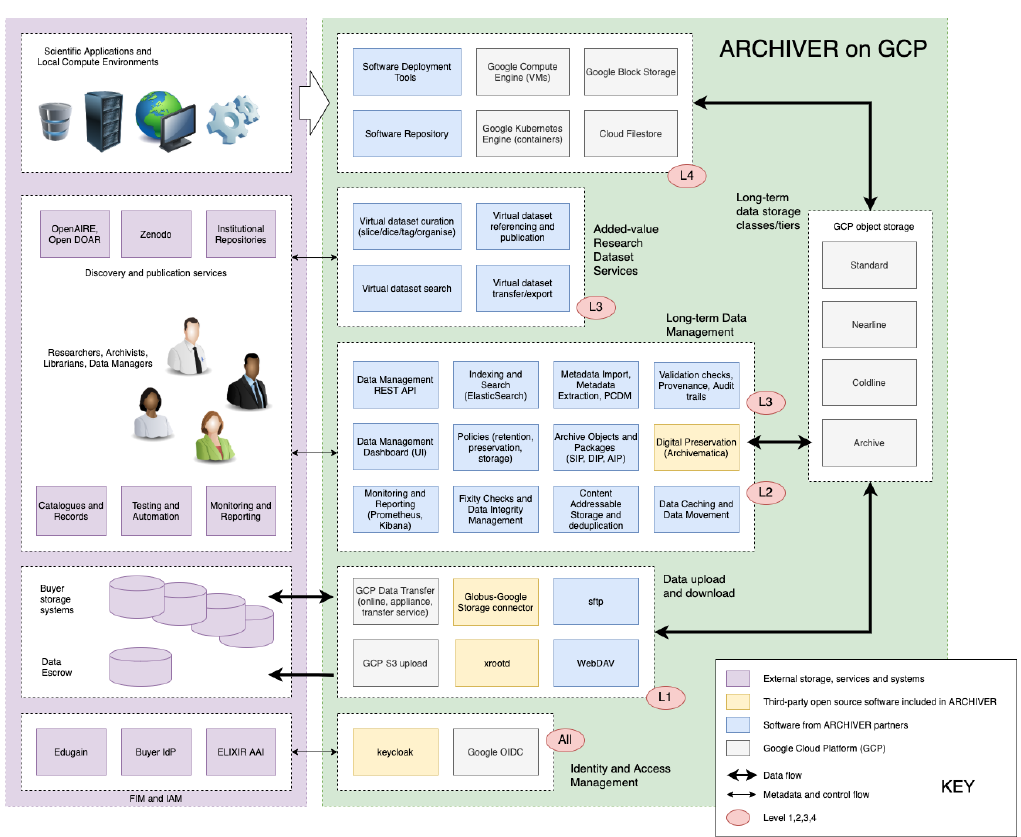
Fig. 8. Prototype architecture of the Arkivum consortium.